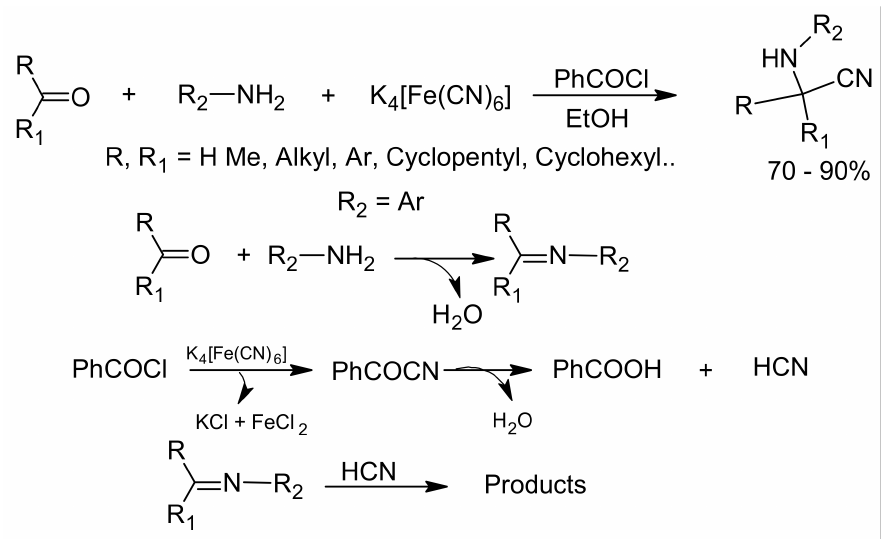
Scheme 4. Green synthesis of α -amino nitriles in the presence of potassium ferrocyanide and its